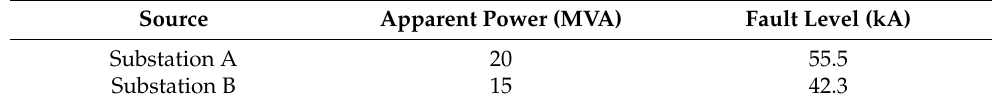
Table 2. Substation